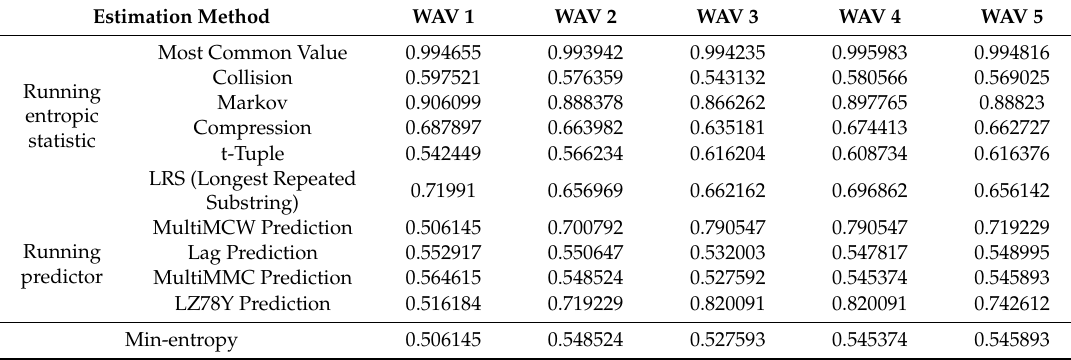
Table 1. Randomness estimation results of 10 radio signals collected from a single channel.